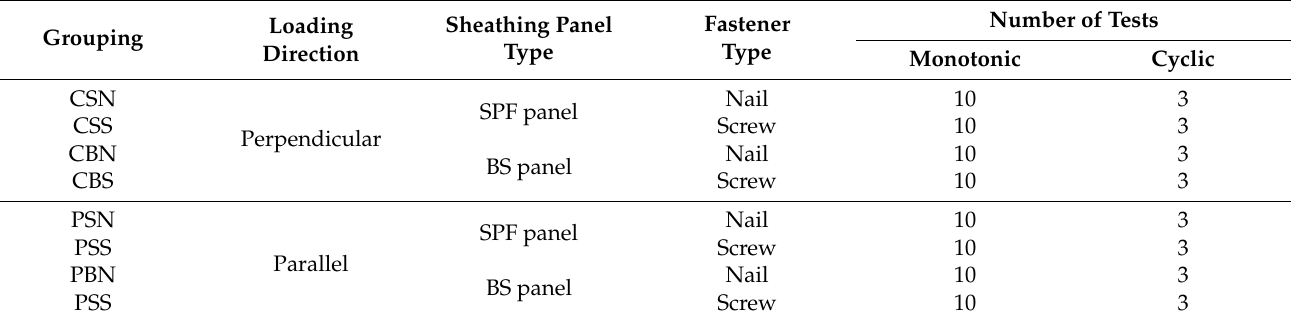
Figure 1. Dimensions and manufacturing details of the test specimens: ( a ) Perpendicular joints; ( b ) Parallel joints. (Unit: mm). Table 1. Parameters of the test specimens.